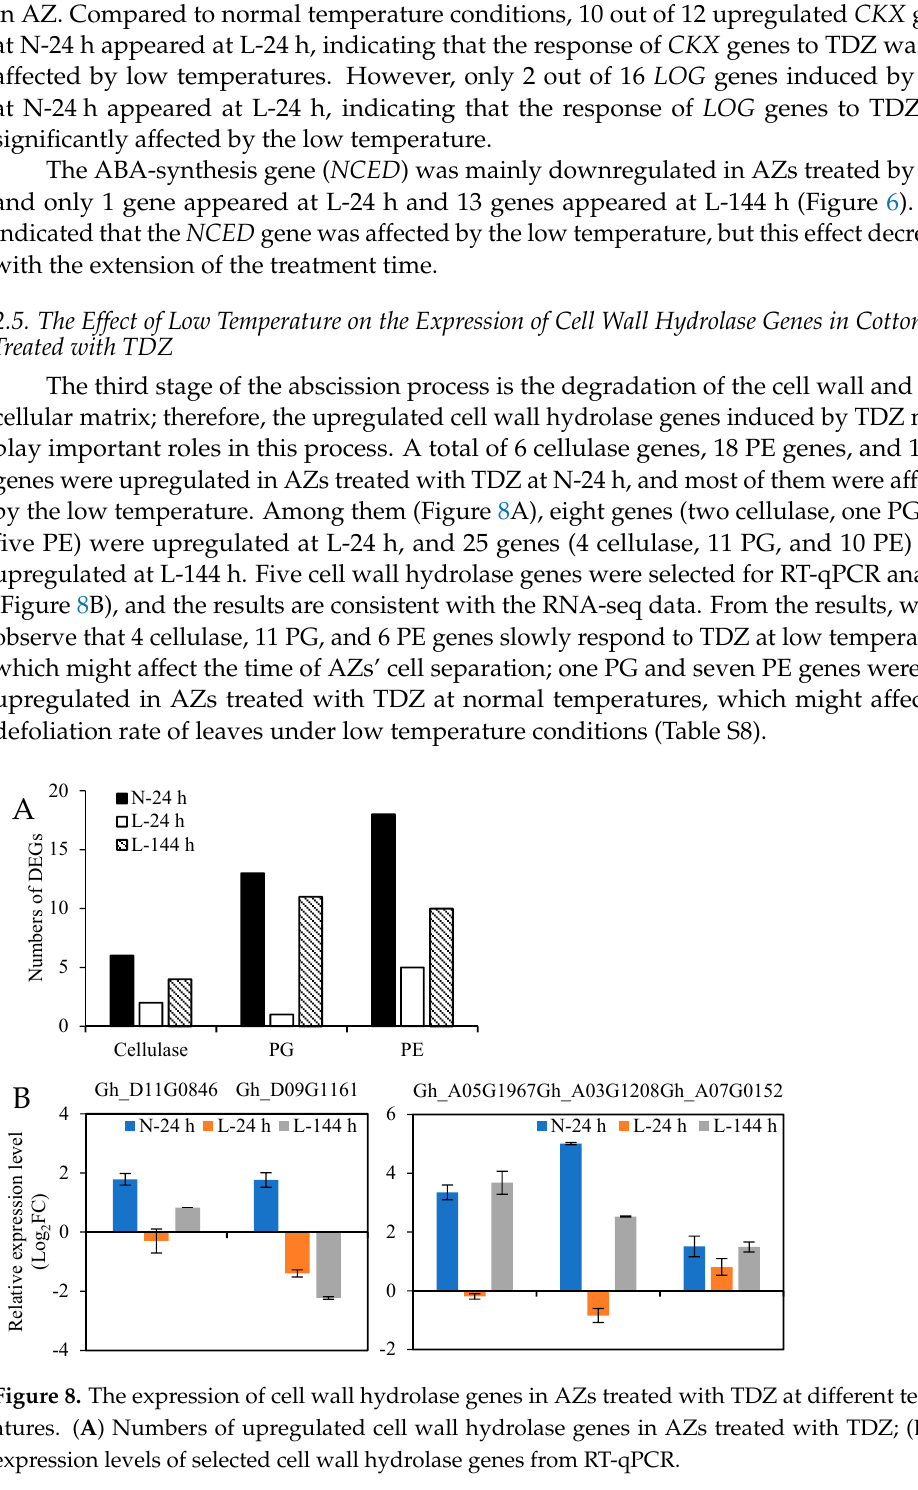
Figure 7. The contents of ACC and IAA in cotton AZs treated with TDZ and water (control) at dif- ferent temperatures. Error bars represent the SD of three biological replicates. ** p < 0.01, Student’s t -test.